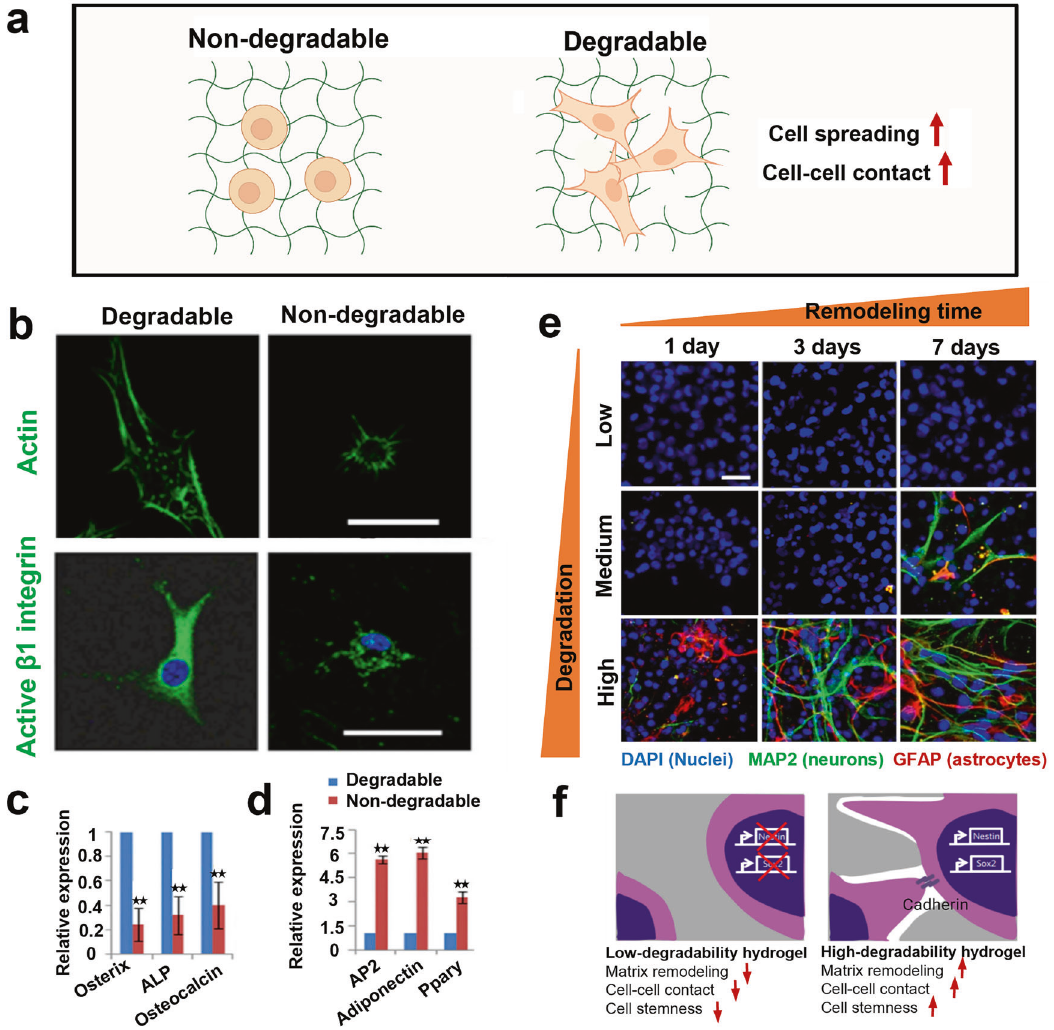
Fig. 7 The in fl uences of hydrogel degradability on cell biology. a Schematic image of the interaction between entrapped cell and degradable/ non-degradable hydrogels. The fi gure is made with biorender (https://biorender.com/). b – d Explorations on how hydrogel degradability promoted stem cell spreading and β 1 integrin activation within 3D PEG-based hydrogels ( b ) and induced distinctive differentiation preference ( c , d ), e.g., osteogenesis and adipogenesis within the degradable and non-degradable hydrogel, respectively. ** p < 0.01. Reproduced with permission. 275 Copyright 2013, Elsevier. e , f Tests indicating how hydrogel degradability enhanced neural stem cells ’ stemness ( e ) via permitting cell – cell contact and inducing Nestin and Sox2 expression ( f ). Reproduced with permission. 17 Copyright 2017, Springer